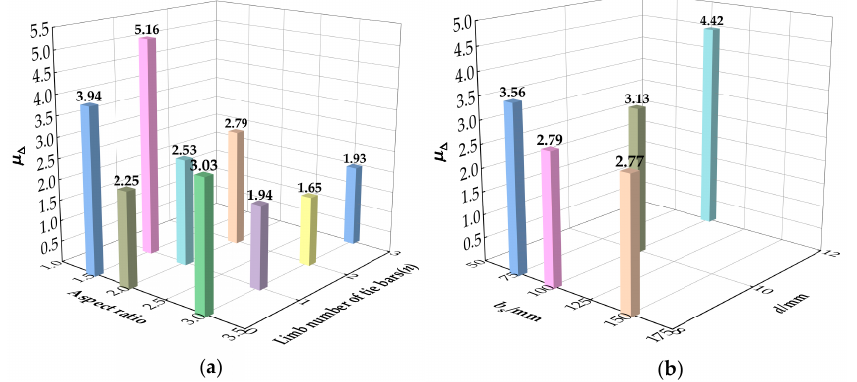
Figure 13. Displacement ductility: ( a ) With different aspect ratio and limb number of tie bars; ( b ) With different b s and d . The ability of energy absorb for the RCFST columns can be described by energy ductility index µ E . The energy ductility index can be presented by µ E = A u / A b , where A u and A b are the envelope areas under the load curve of the coordinate origin to the ultimate point and yield point, respectively [39]. Figure 14 demonstrates the regions of A u and A b . The energy ductility of the columns shows a similar variation to the displacement ductility, as shown in Figure 15. Similarly, the diameter of tie bars from 8 mm to 12 mm had greatly enhanced energy ductility by 85.1%.